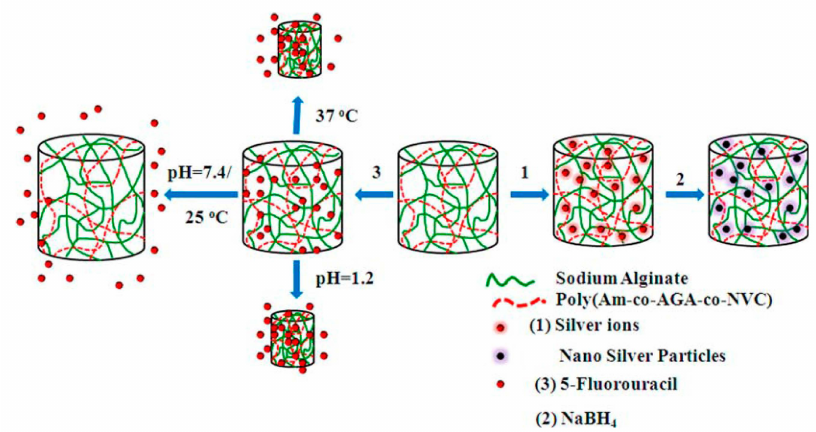
Figure 2. Synthesis and dual responsive-triggered release of the drug from semi-Interpenetrating Polymeric Networks (semi-IPNs) of SAlg-P(AAm- co -AGA- co -NVCL) multi component gels and the formation of Ag NPs in the hydrogel networks. (Reproduced from Rama Subba Reddy et al., Macromol. Res. 2014 , 8 , 832–842. (Ref. 74) copyright 2014 with permission from